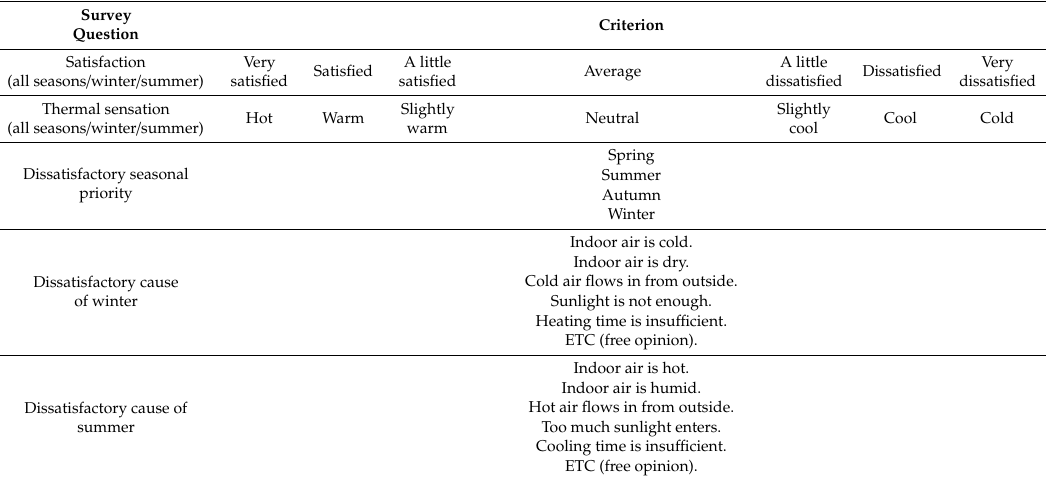
Table 3. Survey question and